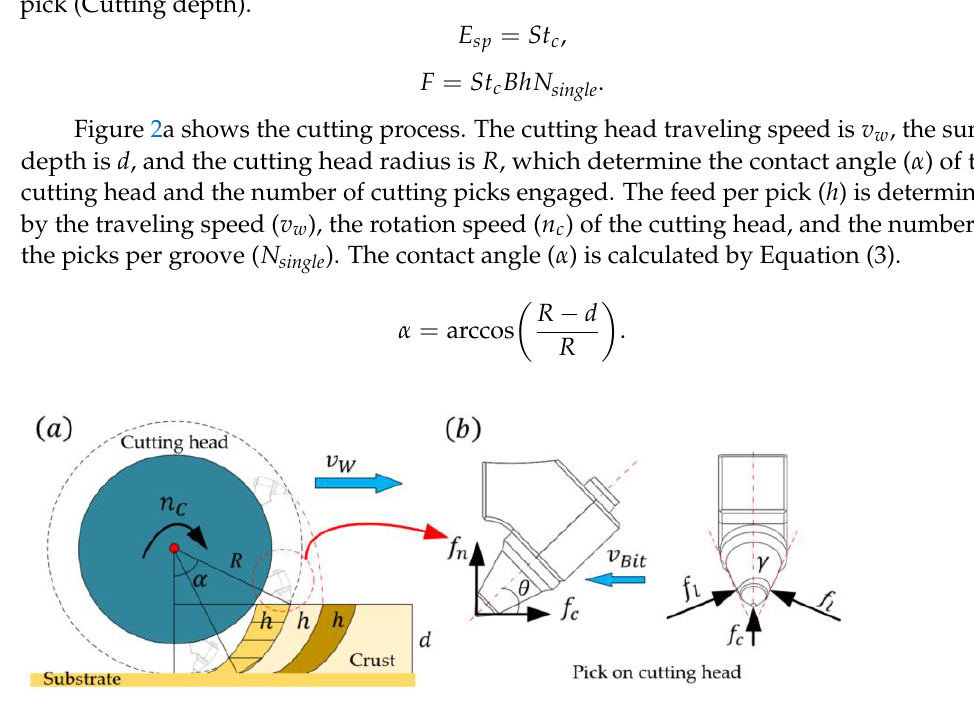
Figure 2. ( a ) Schematic diagram of the cutting process. ( b ) Forces on a single pick.